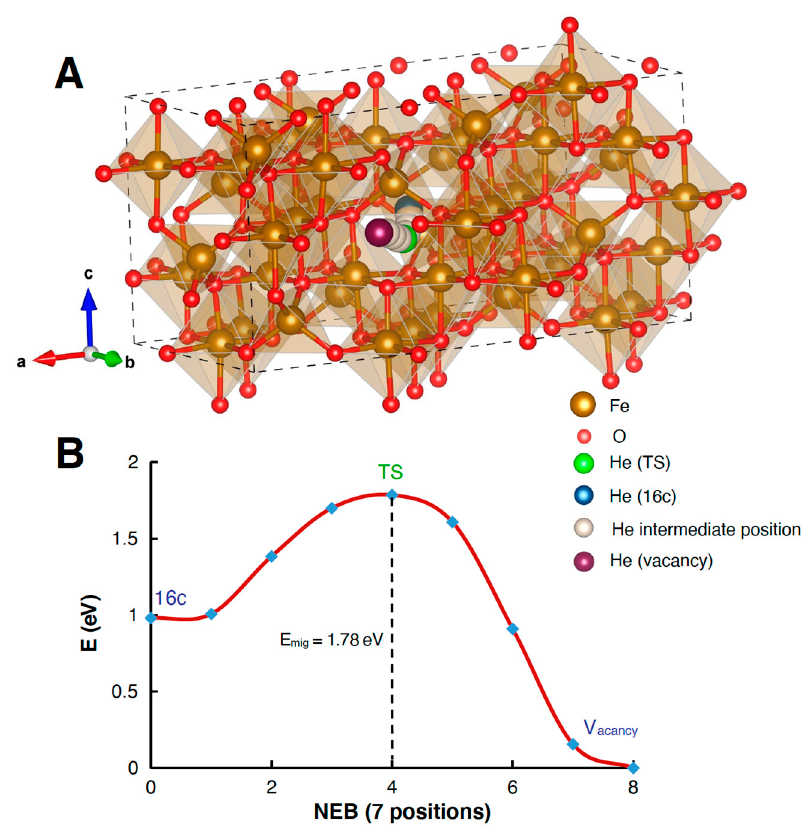
→ → → v 1 × v 2 × v 3 ) cell. ( A ) view of the NEB migration